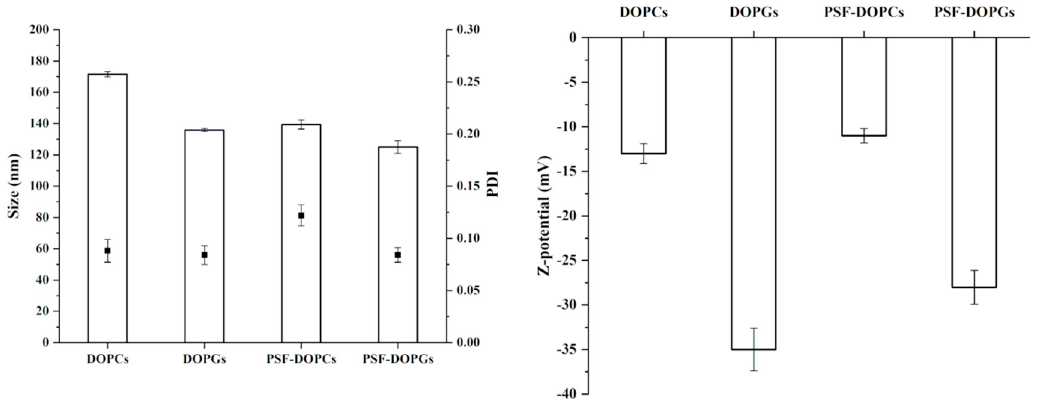
Figure 2. Characterization of formulated vesicles by Z-average size, polydispersity index (PDI), and Z-potential. DOPCs and DOPGs revealed an average size of 171 nm and 135 nm, respectively, a narrow size distribution (PDI below 0.13) and a surface charge of − 13 mV and − 35 mV, respectively. PSF incorporation did not significantly affect size distribution, while we could observe some differences regarding the average diameter and surface charge (Figure 1). PSF incorporation induced a significant reduction of vesicle size for the DOPCs (171 vs. 140 nm before and after PSF-loading, respectively), while the effect was only min- imal for the DOPGs (135 vs. 125 nm before and after PSF-loading, respectively). On the contrary, DOPGs showed a significant reduction of the surface charge after PSF incorpo- ration ( − 35 vs. − 28 mV before and after PSF-loading, respectively), while a very slight dif- ference could be observed for the DOPCs ( − 13 vs. − 11 mV before and after PSF-loading, respectively). Taken together, these findings reveal a different effect of PSF incorporation in the two formulations, which was predictable considering both the heterogeneity of PSF com- position and the net difference between DOPC and DOPG, which confer distinct physico- chemical properties to the vesicles. HPLC chromatograms acquired at 280 nm of purified samples of free PSF, PSF-DOPCs and PSF-DOPGs are reported in Supplementary Figure S1, and the characterization of the main phenolic compounds is reported in Table S1 in the Supplementary Material. As reported in Table 1, the dominant classes of phenolic compounds present in PSF are hydroxycinnamic acid derivatives (44.4%), anthocyanins (32.7%), and flavonoid de- rivatives (21.1%), which is in accordance with literature data [30–32]. Table 1. The total concentration of phenolic compounds in P. spinosa fruit ethanolic extract (free PSF) and in extract-loaded vesicles (PSF-DOPCs and PSF-DOPGs). Peak No